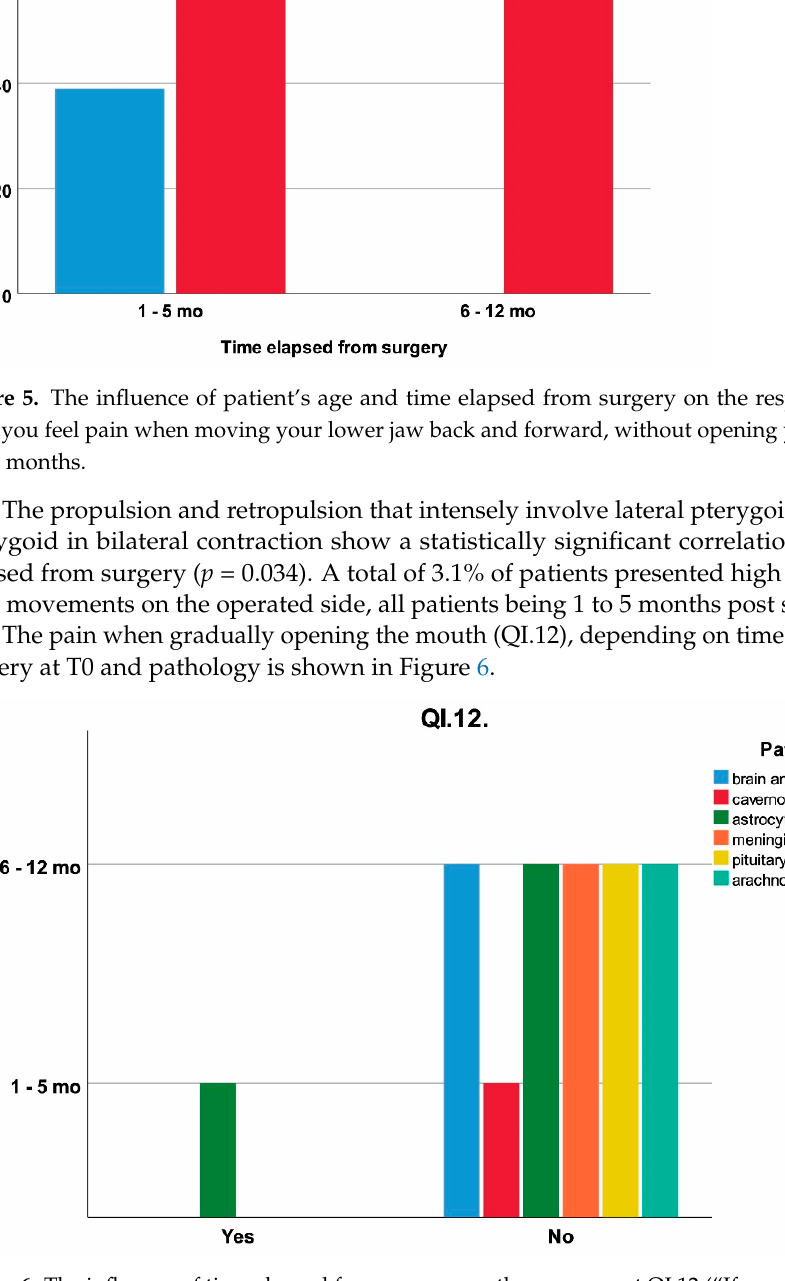
Figure 6. The influence of time elapsed from surgery on the response at QI.12 (“If you open wide and then gradually close your mouth, do you feel pain on the affected side?”) clustered on pathology; mo = months.